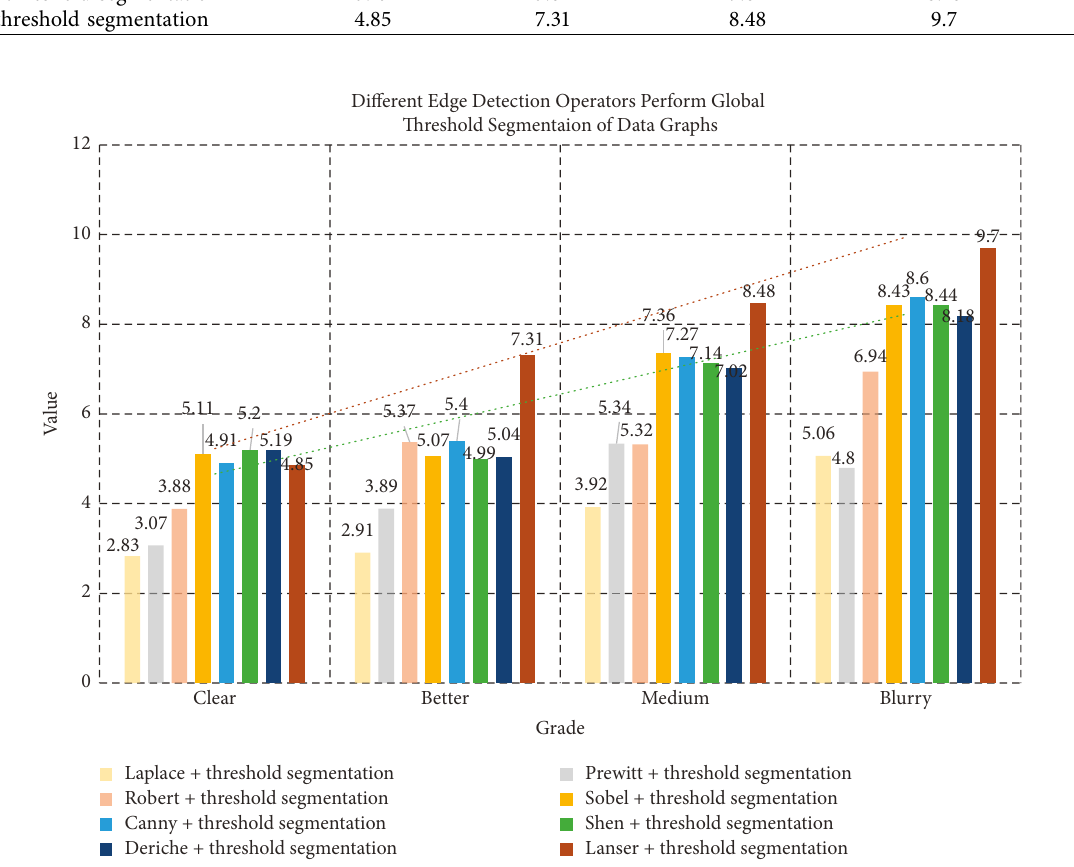
Figure 3: Different edge detection operators perform global threshold segmentation of data graphs. Table 5: Different threshold segmentation methods to process the image data